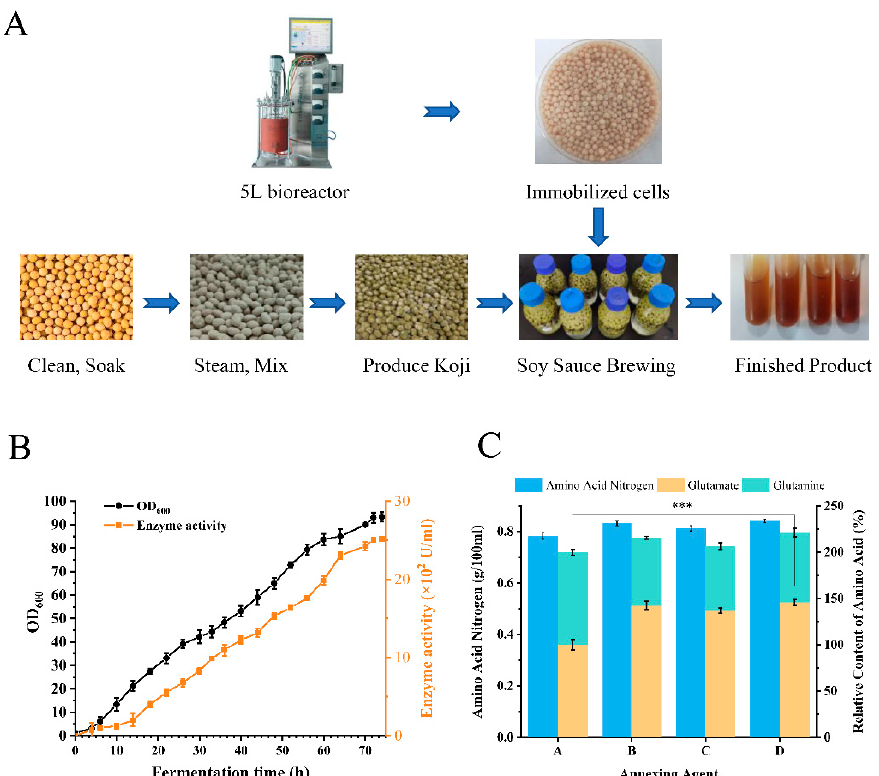
Figure 6. Fermentation, immobilization, and soy sauce brewing. ( A ) BSW3 was fermented in a 5-L bioreactor, and 500 mL of cells were immobilized after fermentation; the resulting immobilized cells were added to the HSDS soy sauce brew in six portions. ( B ) The fermentation process parameters of the recombinant strain BSW3 in 5-L fed-batch fermentation. ( C ) Levels of amino acid nitrogen, glutamate, and glutamine in the produced soy sauce. Group A was the control group, the cell-disrupting crude enzyme was added to group B, washed whole cells were added to group C, and immobilized cells were added to group D. Each experimental data point represents the average of three independent experiments, and the error bars indicate standard deviations. *** p < 0.005.